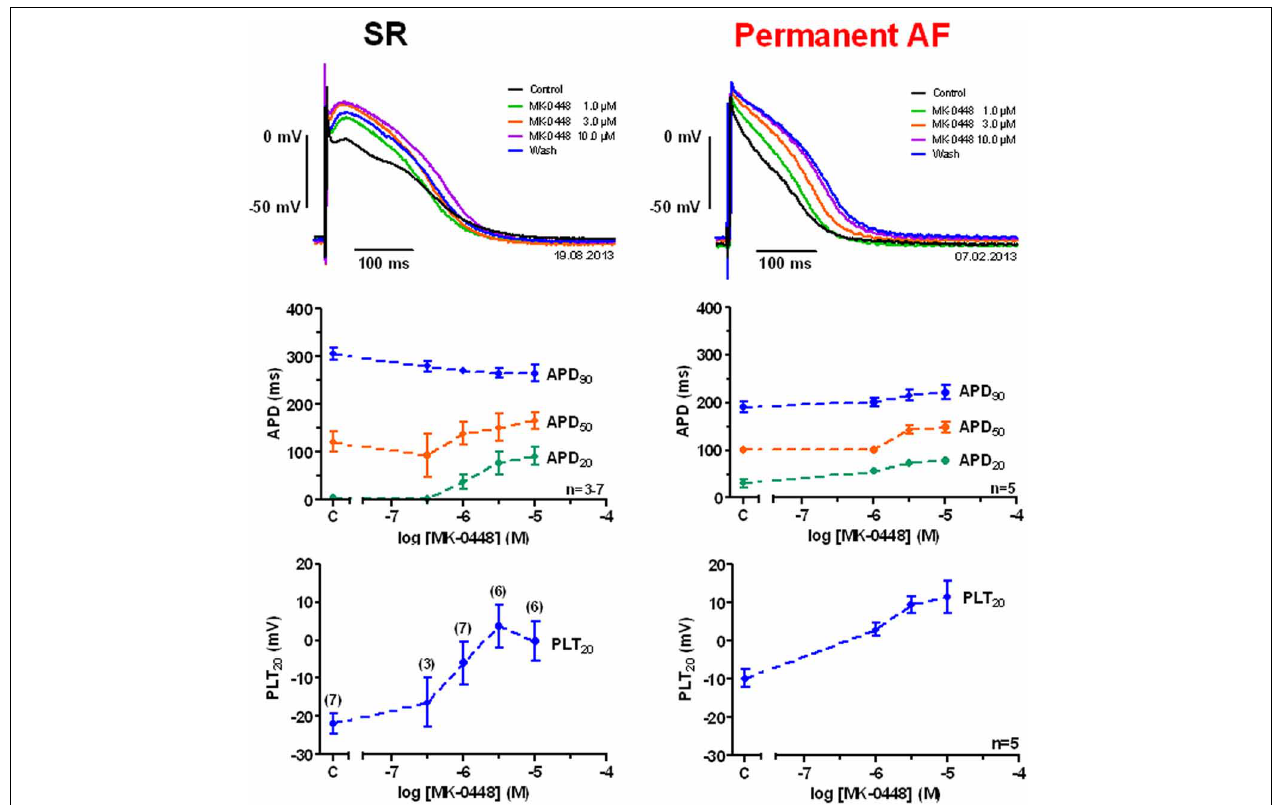
FIGURE 2 | Concentration-dependent effects of MK-0448 on action potentials recorded in right atrial trabeculae from patients in sinus rhythm (SR) and permanent atrial fibrillation (AF). Top: Individual tracings for typical experiments, recorded in the presence of increasing concentrations of compound (see color code). Exposure time at each concentration: 20min; control: pre-drug control. Middle